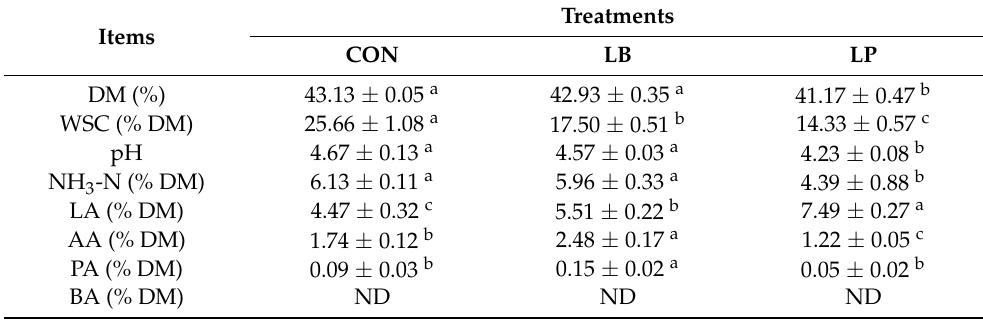
Table 3. Fermentation quality of the forage oat silage.